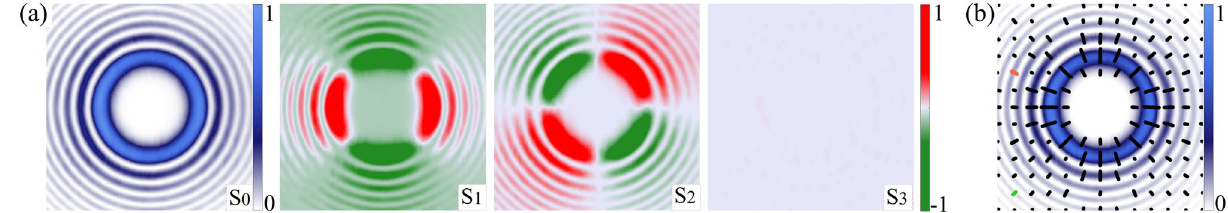
Figure 6. Experimental Stokes parameters S 0 , S 1 , S 2 and S 3 of the vector mode (cid:31) 1, − 1 are represented in ( a ), respectively, from which the polarization distribution can be reconstructed, as shown in ( b ), where the intensity profile is also